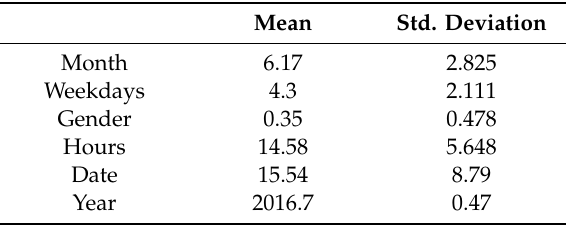
Table 4. Descriptive statistics of correlated variables.